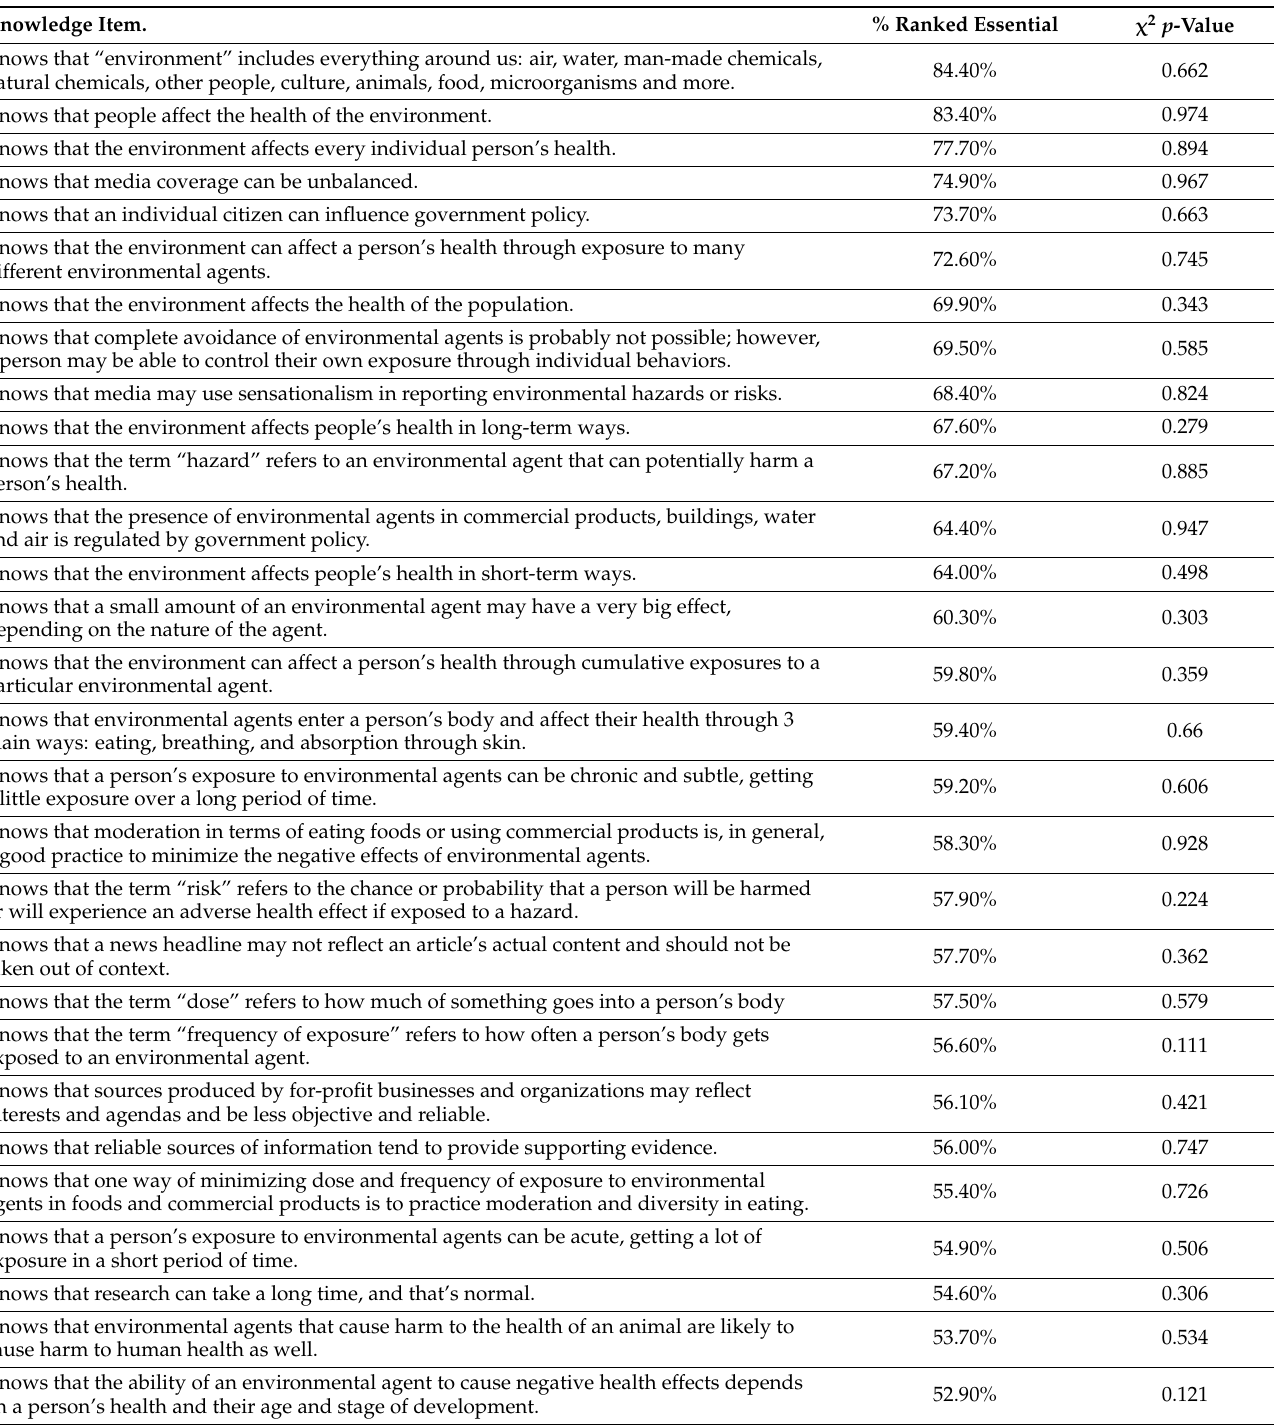
Table 1. Highest Cluster of Essential Knowledge